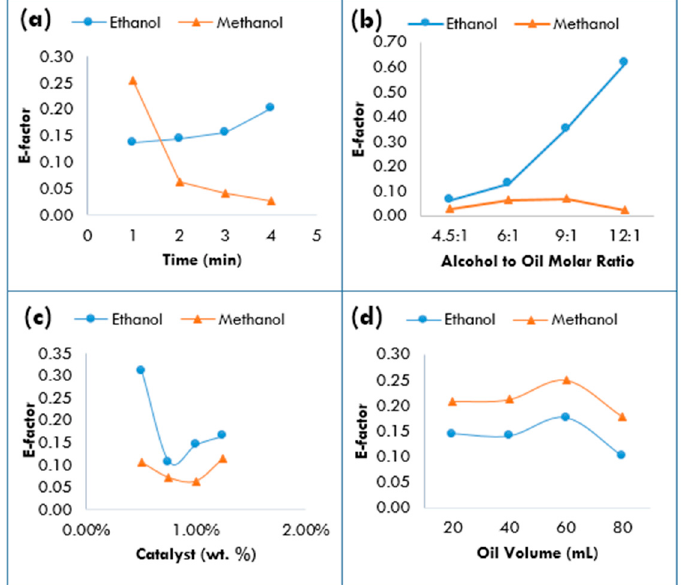
Figure 2. Environmental factor results for the simultaneous effect of microwave and ultrasound (MW/US) in the waste cooking oil (WCO) transesterification. Effect of ( a ) different reaction time; ( b ) alcohol to oil molar ratio; ( c ) catalyst concentration and ( d ) sample (oil) volume.